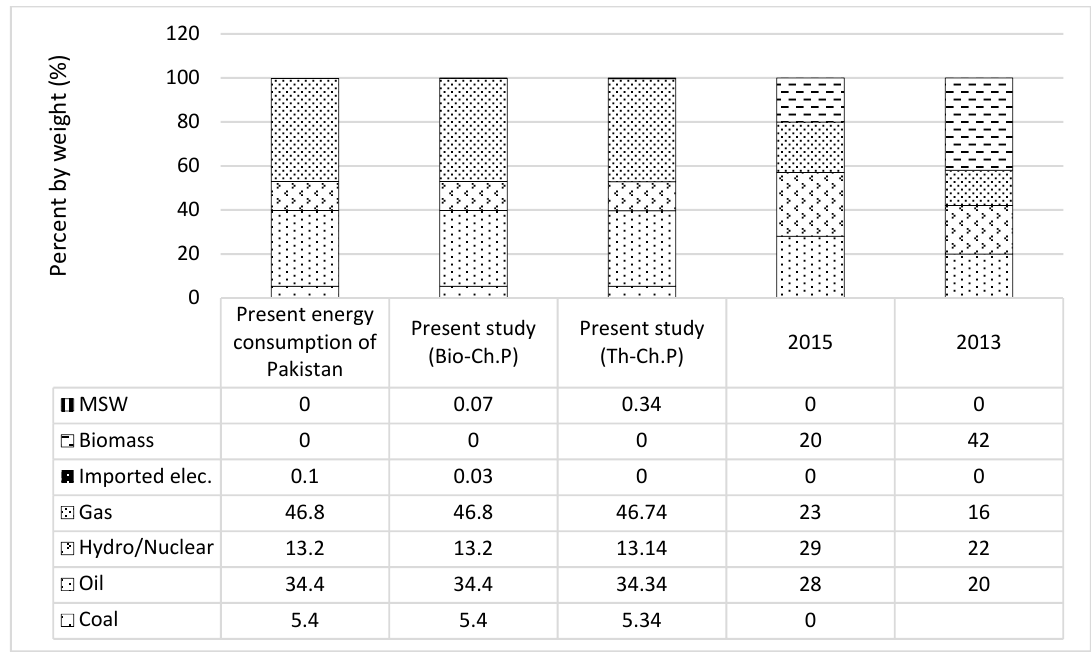
Figure 22. Biomass/MSW contribution in total energy supply.